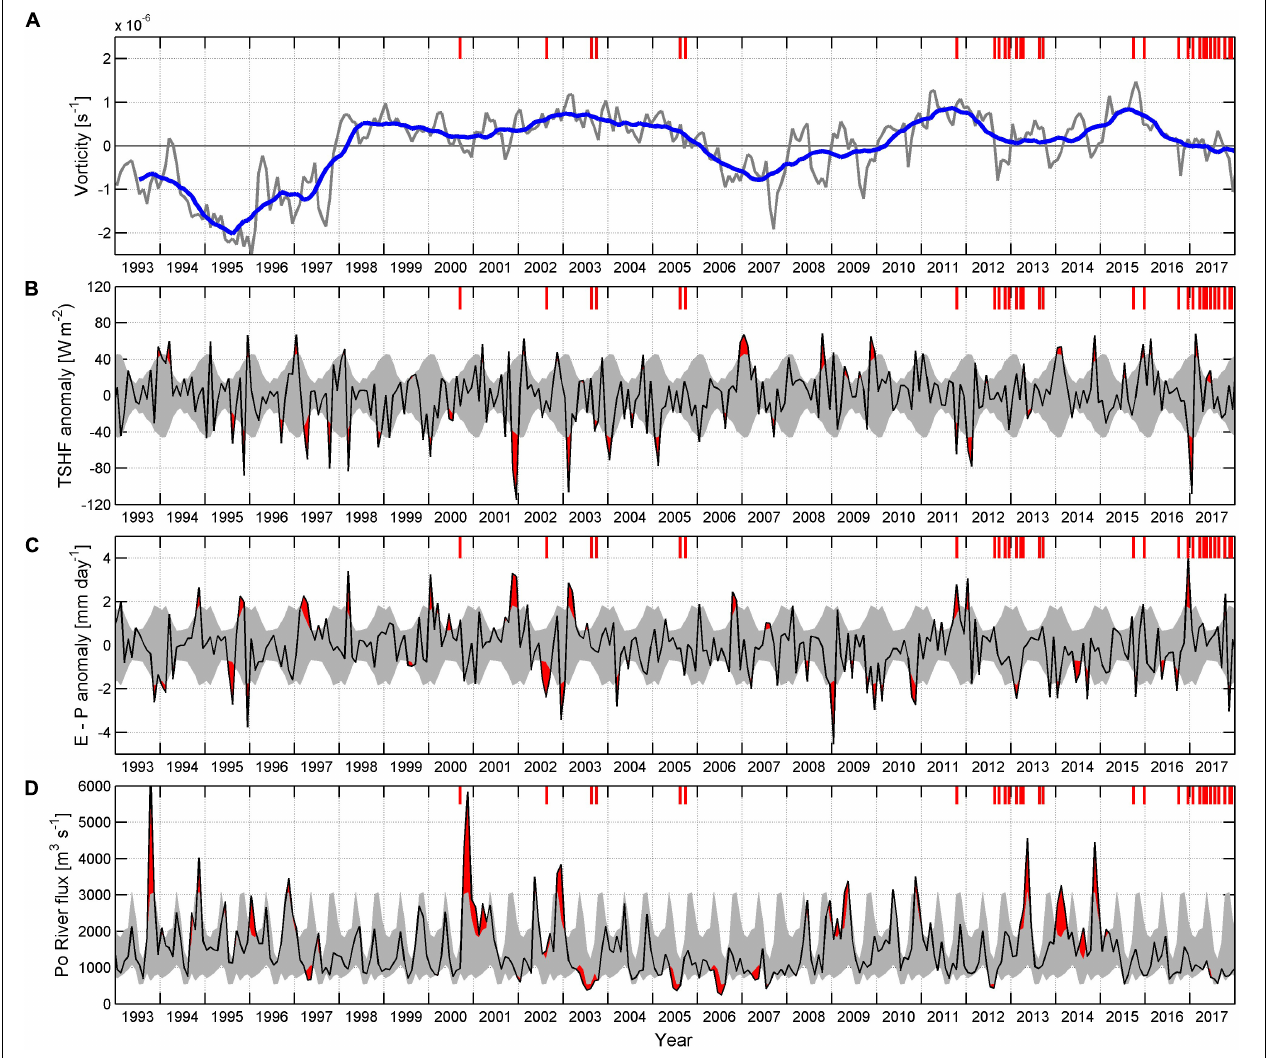
FIGURE 9 | (A) Monthly time series of the spatially averaged current vorticity (gray line) and low-pass filtered (13 months) current vorticity (blue line) computed in the Northern Ionian Sea (37–39 ◦ N; 17–19.5 ◦ E) between January 1993 and December 2017. (B) Monthly ERA-Interim total surface heat flux anomalies and (C) evaporation minus precipitation (E-P) anomalies averaged over the Southern Adriatic, together with (D) monthly Po River discharge between 1993 and 2017. Standard deviations (shaded in gray) were estimated for the period 1979–2017. Red shadings indicate values above or below one standard deviation. Red ticks in the upper part of each panel denote occurrence of surface or near-surface (0–20 m) salinity values higher than 38.8 observed on at least one station along the Palagruža Sill